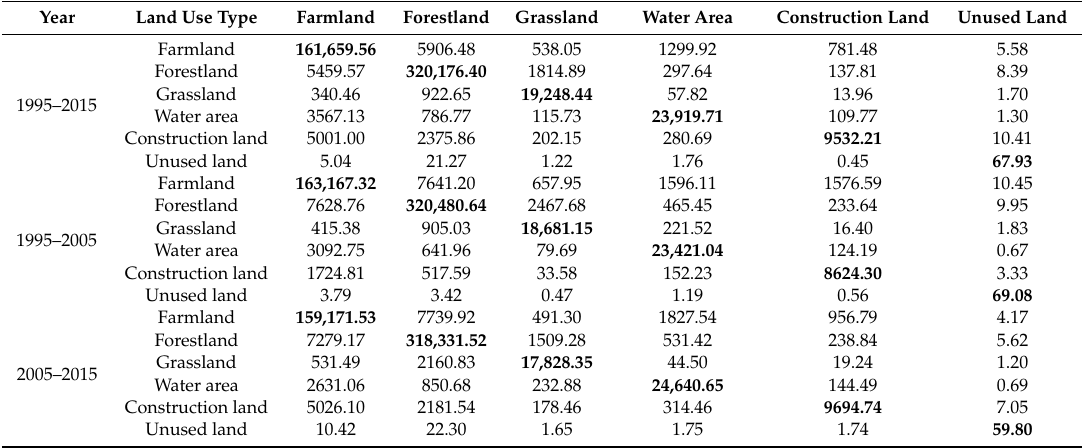
Table 2. Transition matrix of land use from 1995 to 2015 in the